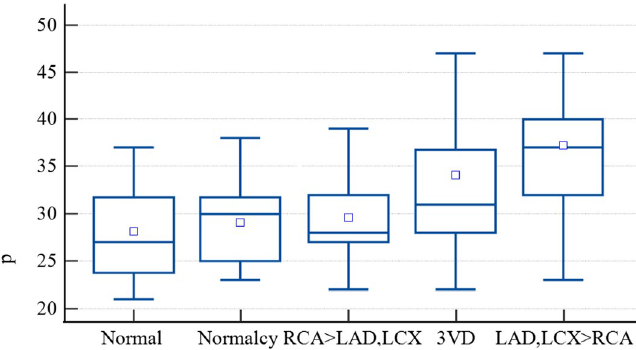
Fig. 11 Quantitative analysis of the stress maximal RV/LV uptake ratio. Box-and-Whisker plots for each subgroup of patients are represented